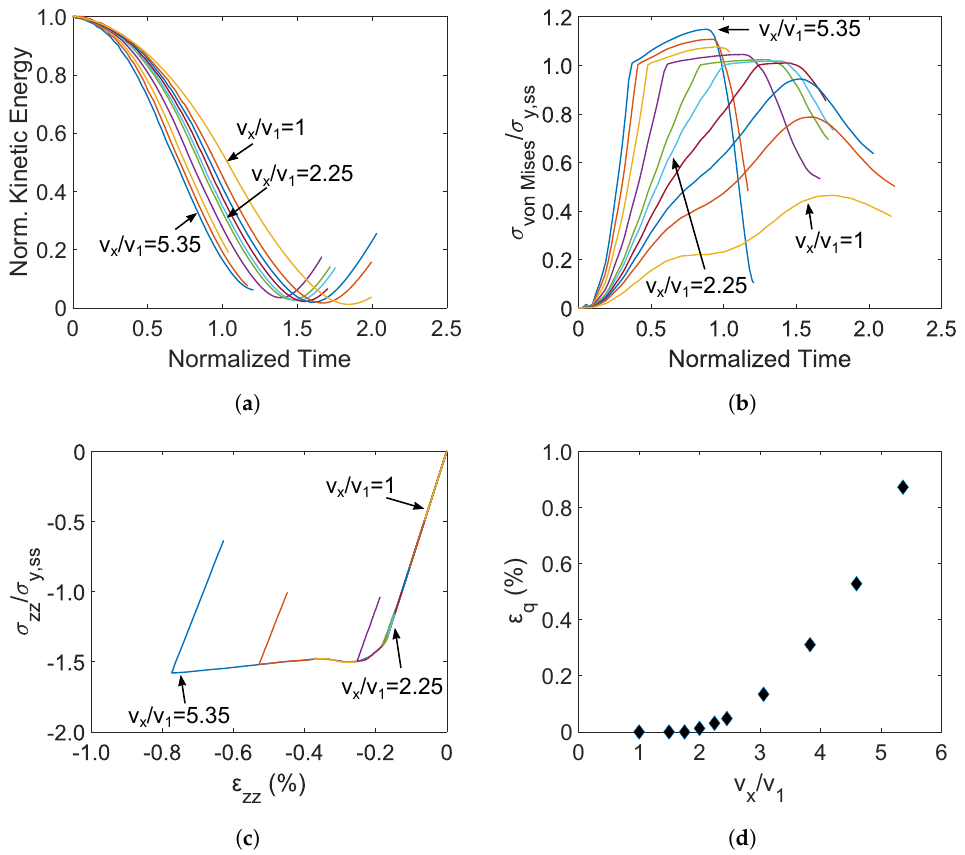
Figure 4. ( a ) Normalized kinetic energy with respect normalized time, ( b ) normalized von Mises stress with respect normalized time at the trailing edge of the foil profile at fixed end, ( c ) normalized normal stress at z -direction with respect the strain at the trailing edge of the foil profile at fixed end, ( d ) equivalent plastic strain, for the different velocities of the killer whale; 304 stainless steel material